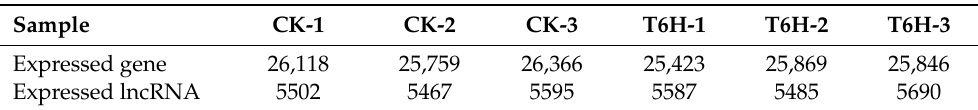
Table 2. Statistics of genes and lncRNA expressed in six libraries constructed from leaves treated with H 2 O and SA.